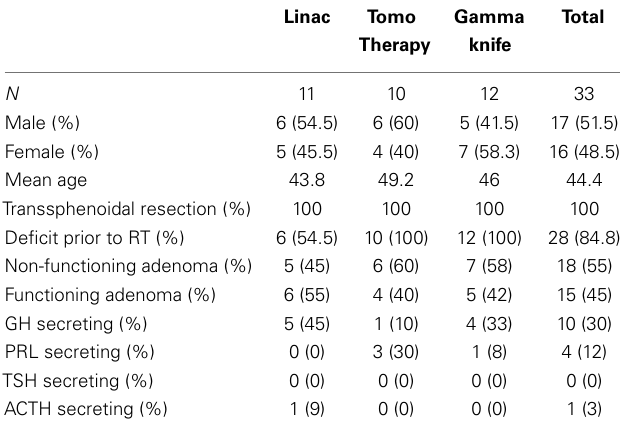
Table 1 | Baseline patient